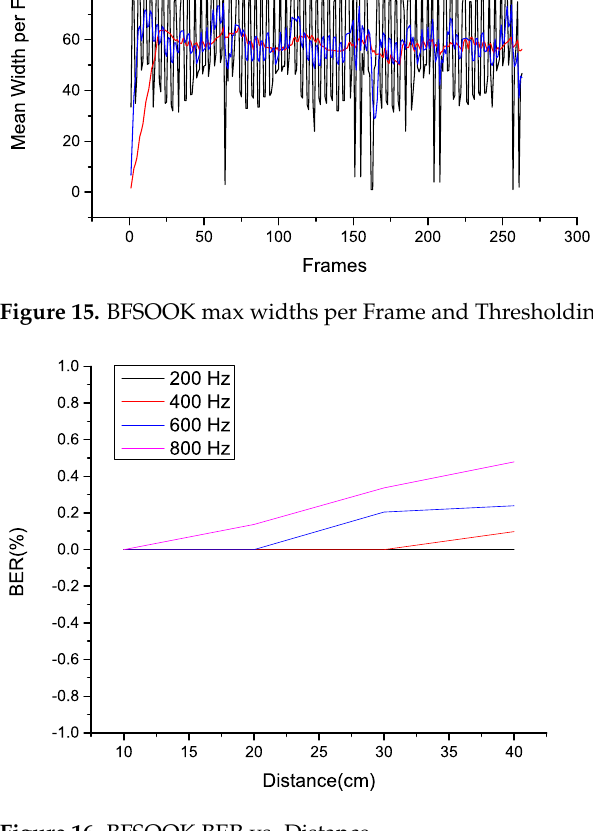
Figure 16. BFSOOK BER vs.